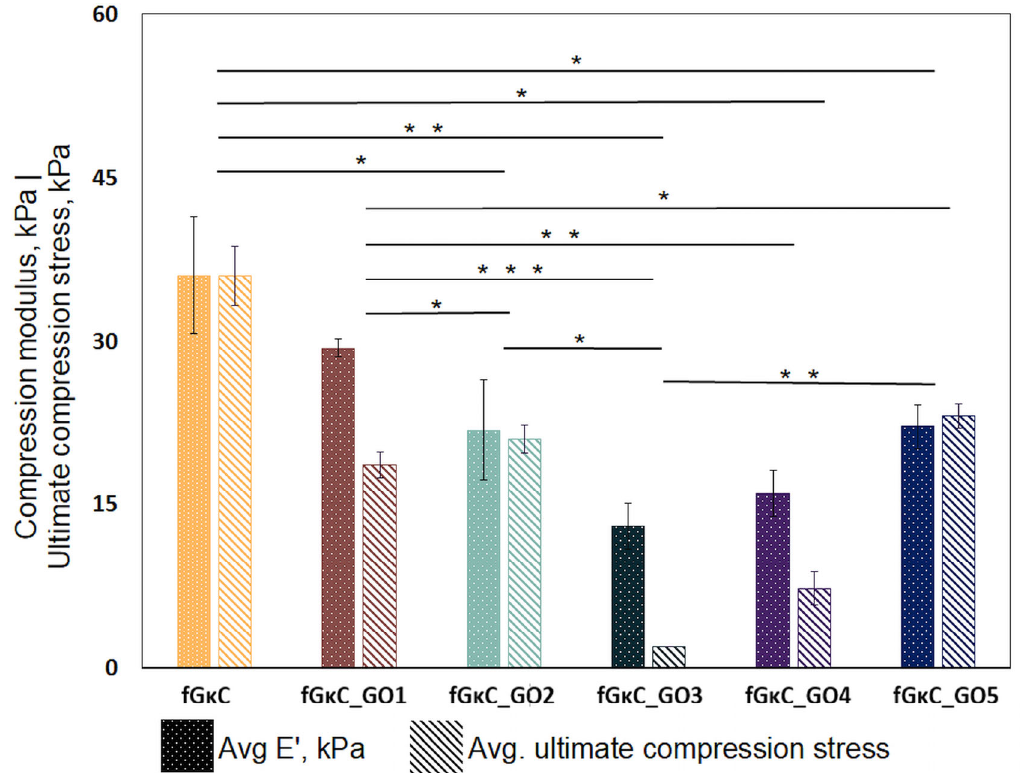
Figure 2. Compression behavior of synthesized materials. *** p < 0.0005, ** p < 0.005 and * p < 0.05 indicate statistical